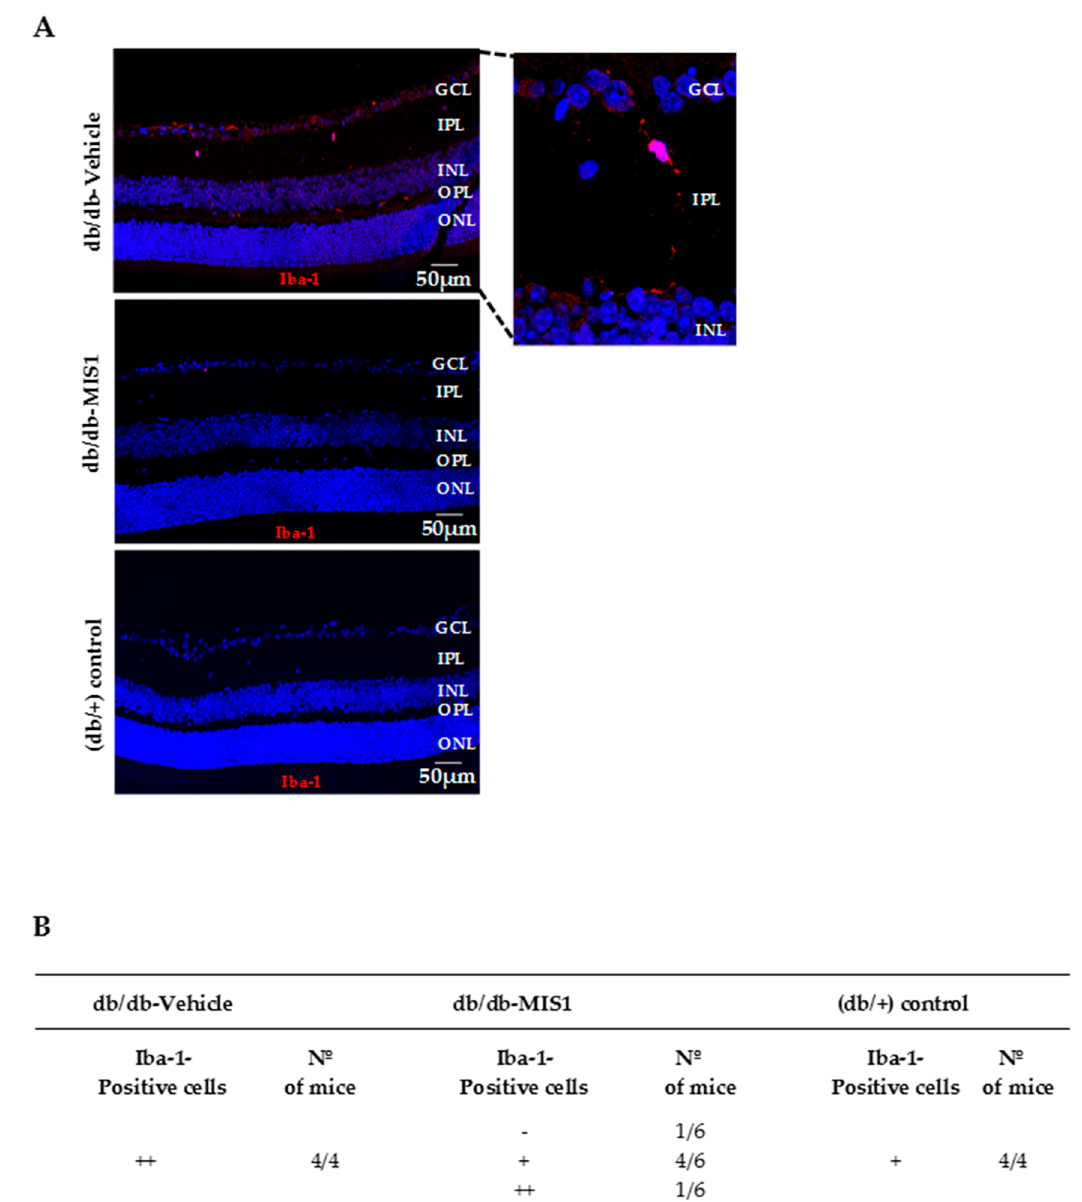
Figure 2. E ff ect of topical (eye drops) SOCS1 peptidomimetic (MIS1) administration on microglial glial activation. ( A ) Representative immunofluorescence of Iba-1 (red) in representative mice from each group. Scale bars, 50 µ m. ( B ) Semiquantitative assessment of microglial activation in the retina (–: absence of positive cells for Iba-1 / power field (20 × ); + : scattered, 1–3 cell / power field (20 × ); ++ : moderate, 4–10 cells / power field (20 × )). N: 7 mice per group.